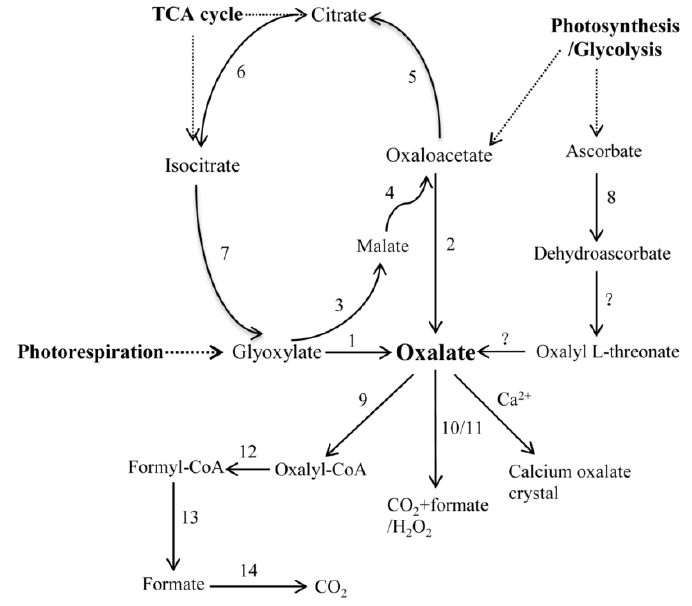
Figure 1. Schematic representation of putative biosynthetic and the degradation pathway of the oxalate (Cai et al., 2015). The enzyme names are as follows: (1) Glycolate oxidase (GLO); (2) Oxaloacetate acetylhydrolase (OXAC); (3) Malate synthase (MLS); (4) Malate dehydrogenase (MDH); (5) Citrate synthase (CTS); (6) Aconitase (ACO); (7) Isocitrate lyase (ICL); (8) Ascorbate peroxidase/Ascorbate oxidase (APX/AO); (9) Oxalyl-CoA synthetase (AAE3); (10) Oxalate decarboxylase (OXDC); (11) Oxalate oxidase (OXO); (12) Oxalyl-CoA decarboxylase (OXDE); (13) Formyl-CoA hydrolase (FXH); and (14) Formate dehydrogenase (FXDE).